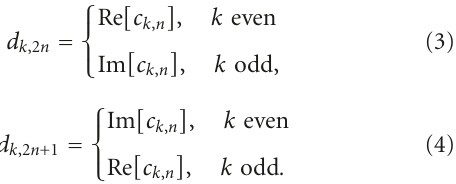
of a complete FBMC/OQAM transmission/reception